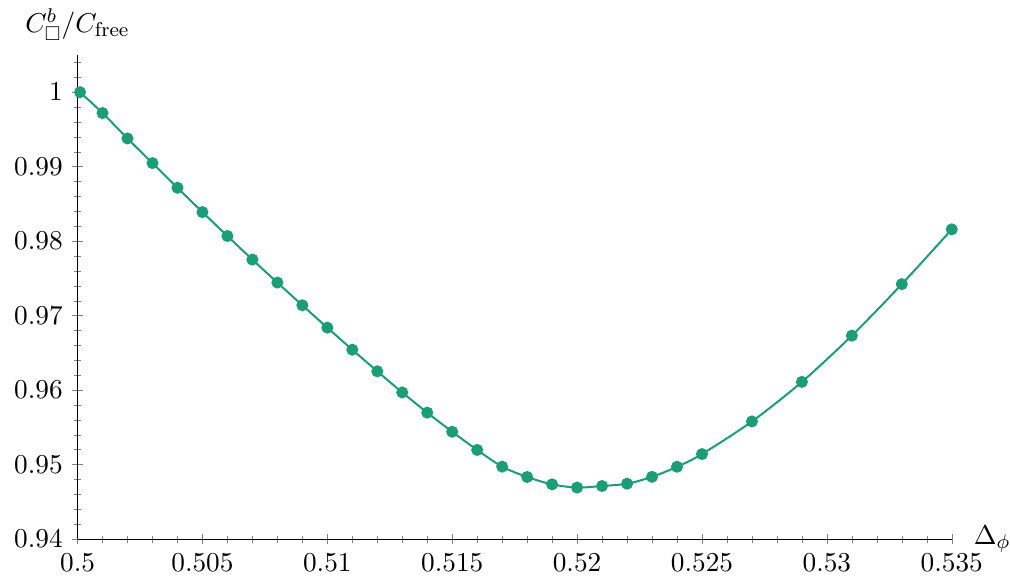
Figure 11 . Value of the central charge of the C b